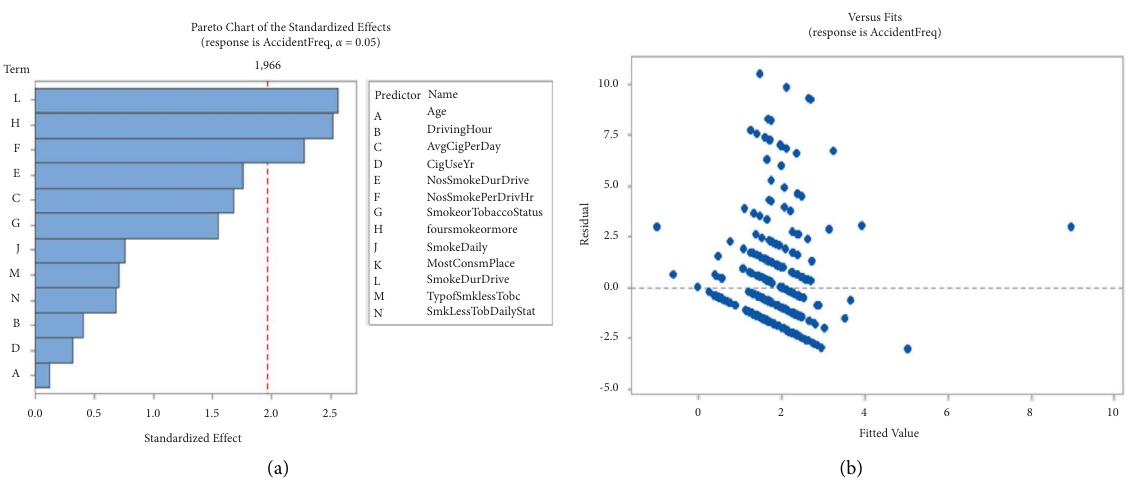
Figure 1: (a) Pareto chart of the standardized efects and (b) versus fts plot of the frst linear regression